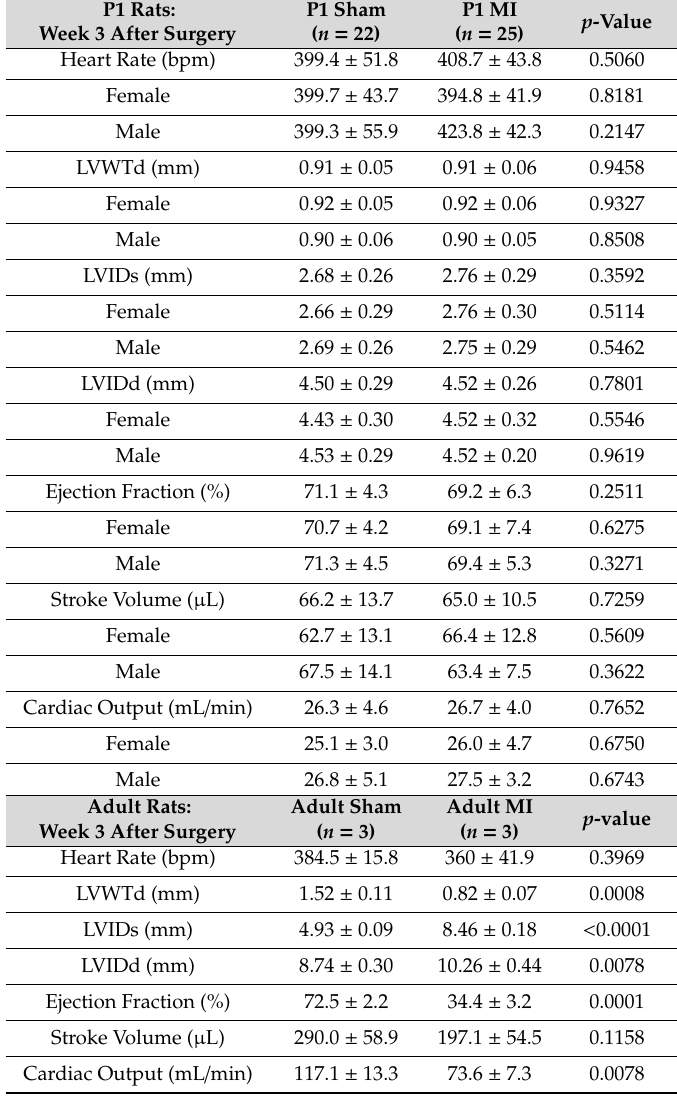
Table 2. Echocardiography assessment at Week 3 after surgery. P1 Rats: Week 3 After